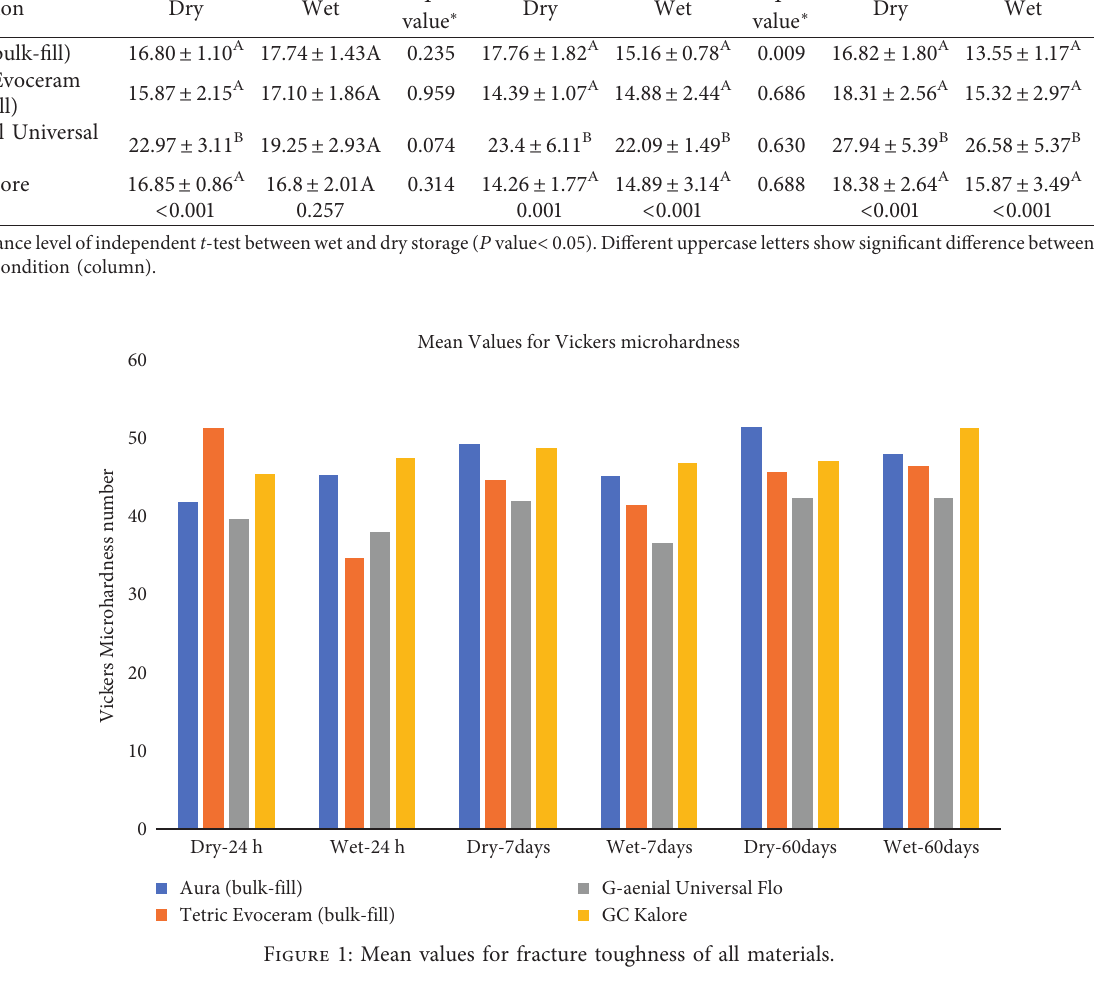
Ic ) between all materials after wet or dry storage, analysed by independent